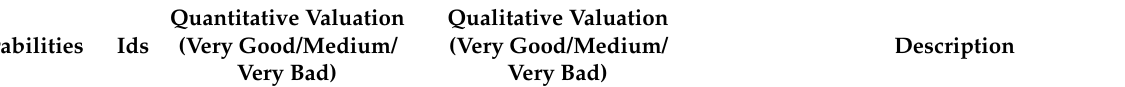
Table 2. Vulnerability input variables